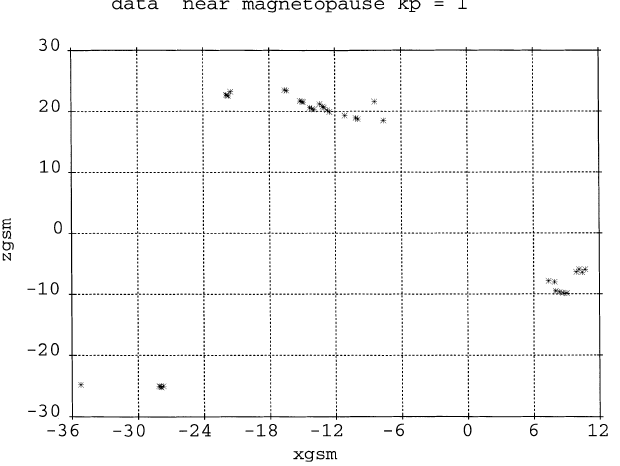
Fig. 4. The data set for Kp = 1 has been filtered to retain points located over the polar regions. Retained points have a ygsm coordinate lower than 5 Re and have a zgsm coordinate higher than zmin . zmin is the local zgsm coordinate of the Sibeck magnetopause minus 2 Re. The lack of data along the magnetopause boundary even within a thickness of 2 Re can be noticed